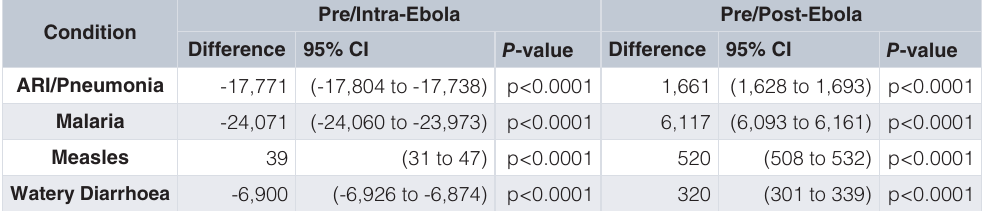
Table 1. Difference in mean monthly consultations for four morbidities between the pre-Ebola (1 June 2013–30 April 2014) period and the intra-Ebola (1 June 2013–30 April 2014) and post- Ebola (1 June 2016–30 April 2017) periods, Sierra